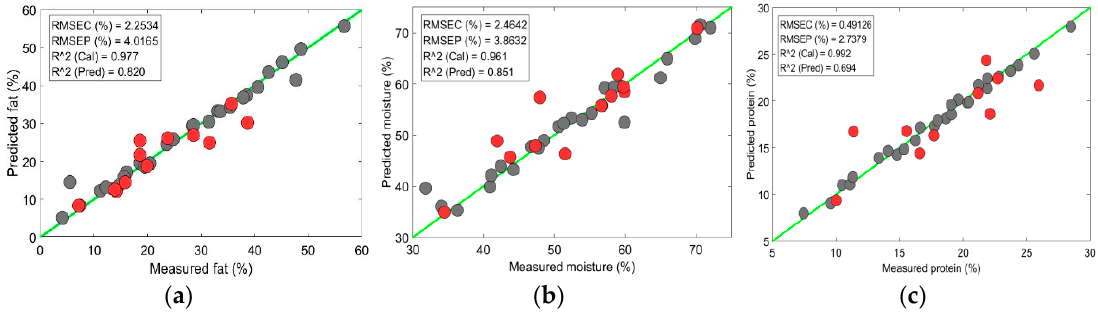
Figure 8. Chemical-component prediction in a sirloin sample: ( a ) Prediction plot of fat content from partial least-squares regression (PLSR) model with outliers included; ( b ) Plot for outlier identification in fat data; ( c ) Prediction of fat content from PLSR model with outliers excluded; ( d ) Prediction of moisture content with SVR model; ( e ) Prediction of protein content with SVR model. The black dots are for calibration sample-set and red dots are for test-sample set.